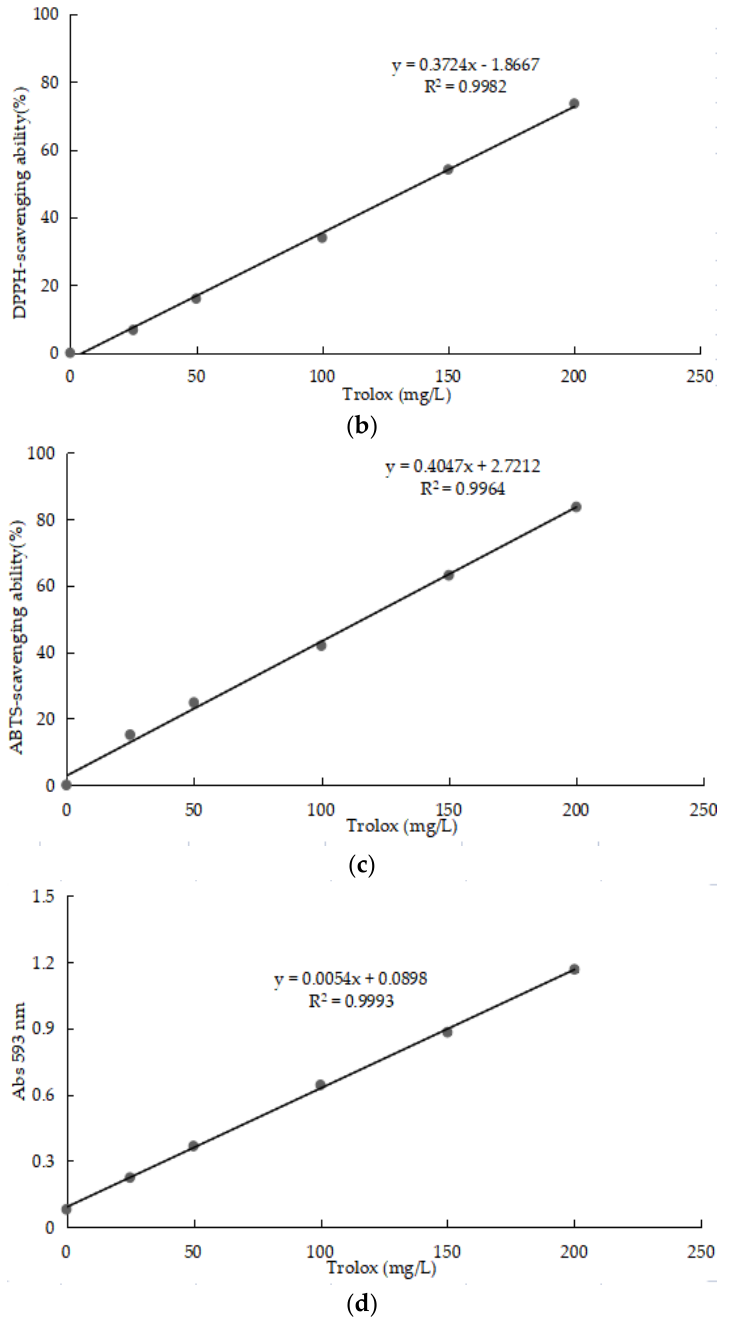
Figure 1. The standard curve of TPC, DPPH-SA, ABTS-SA and FRAP: ( a )TPC standard curve; ( b ) DPPH-SA standard curve; ( c ) ABTS-SA standard curve; ( d ) FRAP standard curve.